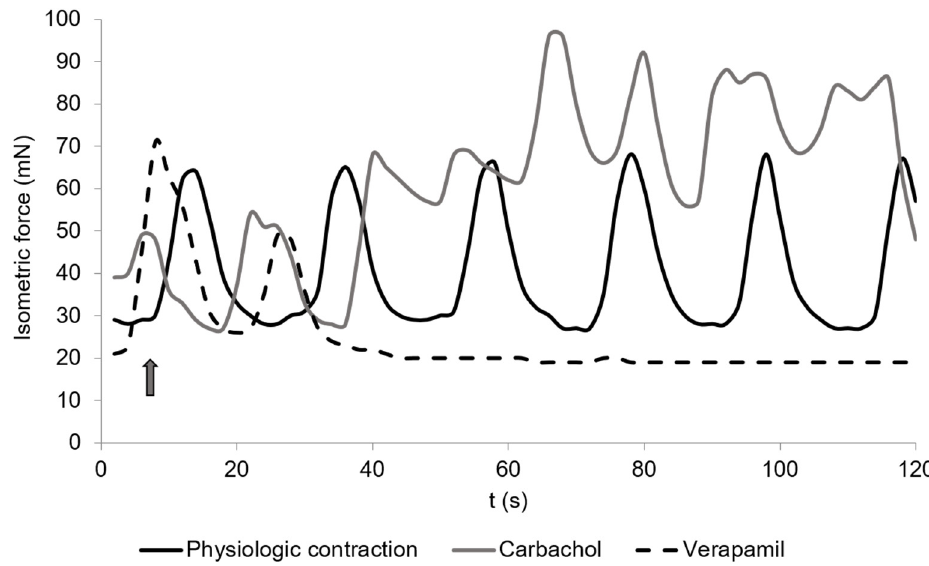
Figure 2. Spontaneous contractions of chicken circular cecal smooth muscle. The control is given (physiological contraction, black) and the reaction to carbachol (10 − 9 mol/L, dark grey) or Verapamil (2 × 10 − 6 mol/L, dashed). The arrow shows the time when drugs were added. The contraction was detected for 2 min. The graph is a typical example from a total of 36 measurements.